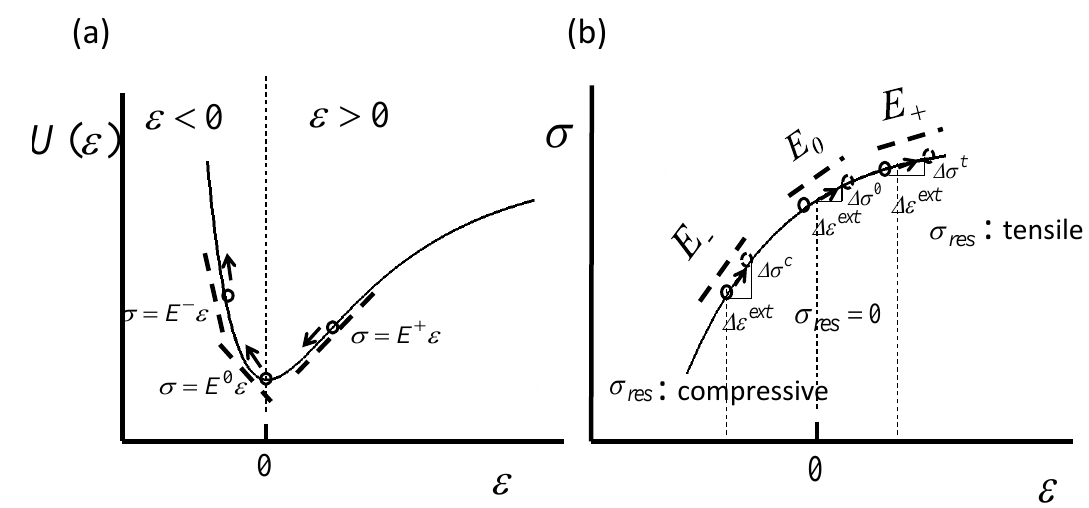
Figure A1. ( a ) Strain potential energy. The slope of the potential energy curve represents the stress; ( b ) The stress as a function of strain. The slope is the elastic